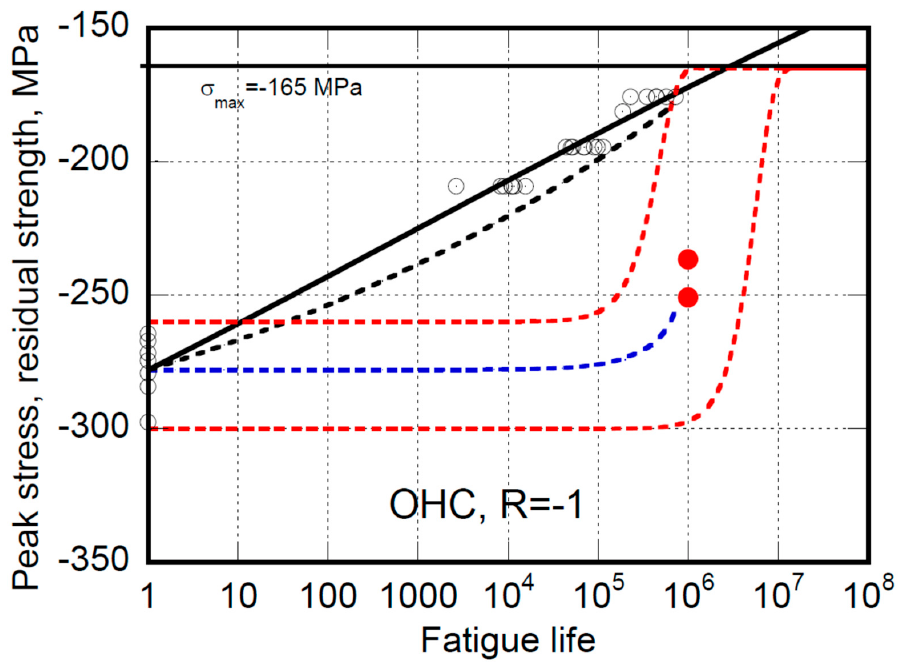
Figure 4. The experimental fatigue life (empty circles) and residual strength data (filled circles) for open hole AS4 / E7K8 PW—10 / 80 / 10 under prevalent compression loadings (OHC) at R = − 1. The continuous curve is the best fit to the fatigue life data based on Caprino’s and D’Amore’s equivalent models. The black broken curve is the predictions of residual strength from Caprino’s model, namely Equation (9). The red broken curves are the predictions of upper and lower bound of residual strength from the D’Amore’s model, namely Equation (12). The blue dotted line represents the Sendekyj’s model’s residual strength predictions, namely Equation (5’’).